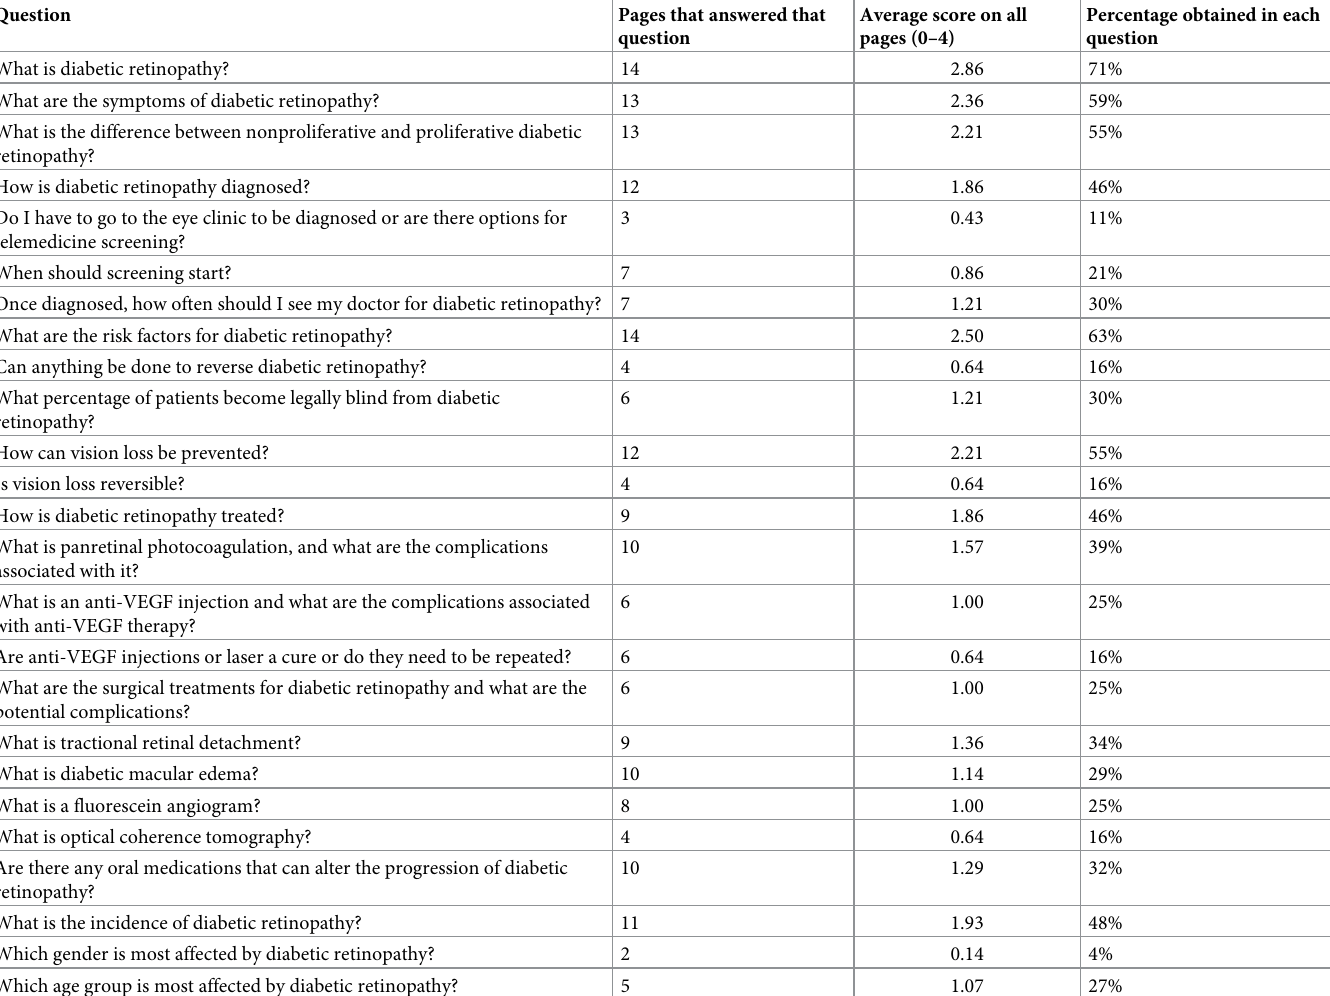
Table 2. Question form for evaluation of information in each language; this represents the survey that was conducted on each Wikipedia page, as well with the num- ber of pages that answered the question, its average score and corresponding percentage for each question in all the languages that were